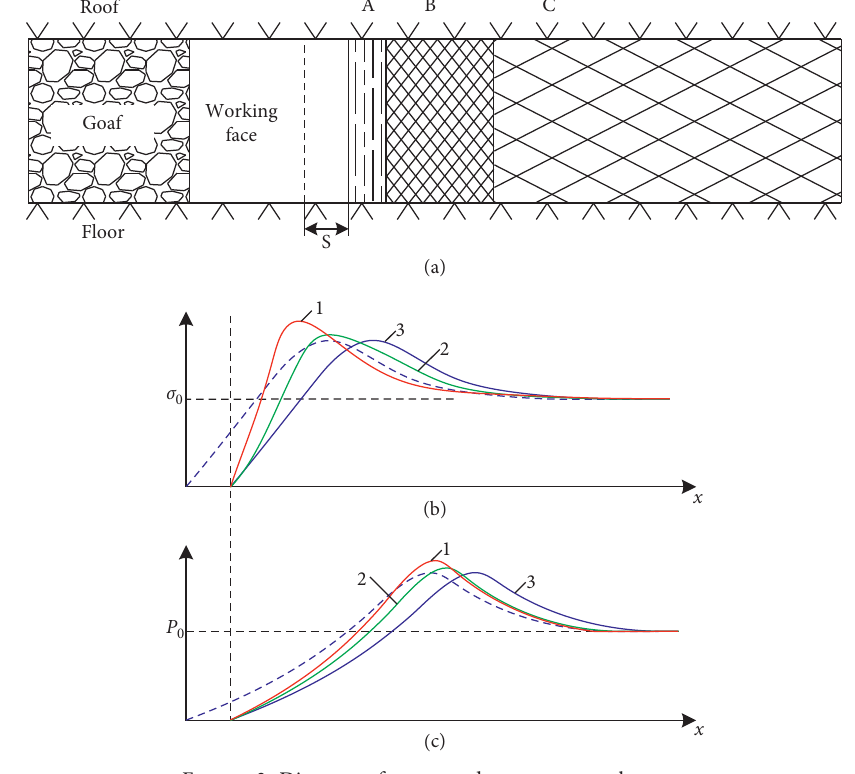
Figure 3: Diagram of stress and gas pressure